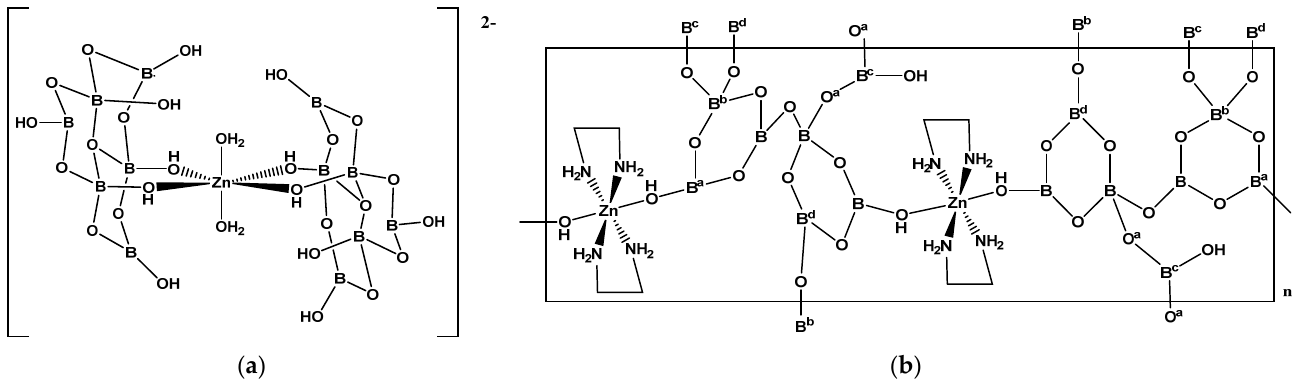
Figure 9. Drawings of (a ) the insular anion in (NH 4 ) 2 [Zn(H 2 O) 2 {B 6 O 7 (OH) 6 } 2 ] · 2H 2 O ( 43 ), and ( b ) the repeating unit of [{Zn(en) 2 {B 7 O 10 (OH) 3 } 2 ] n ( 46 ). {{Zn(en) 2 B 7 O 10 (OH) 3 } 2 ] n ( 46 ), also formulated as [Zn(en) 2 {B 7 O 12 (OH)}] in Ref. [9], is a 3- [Zn(en) 2 {B 8 O 11 (OH) 4 }] n ( 47 ) [10] was reported in 2017 and has a similar stoichiometry